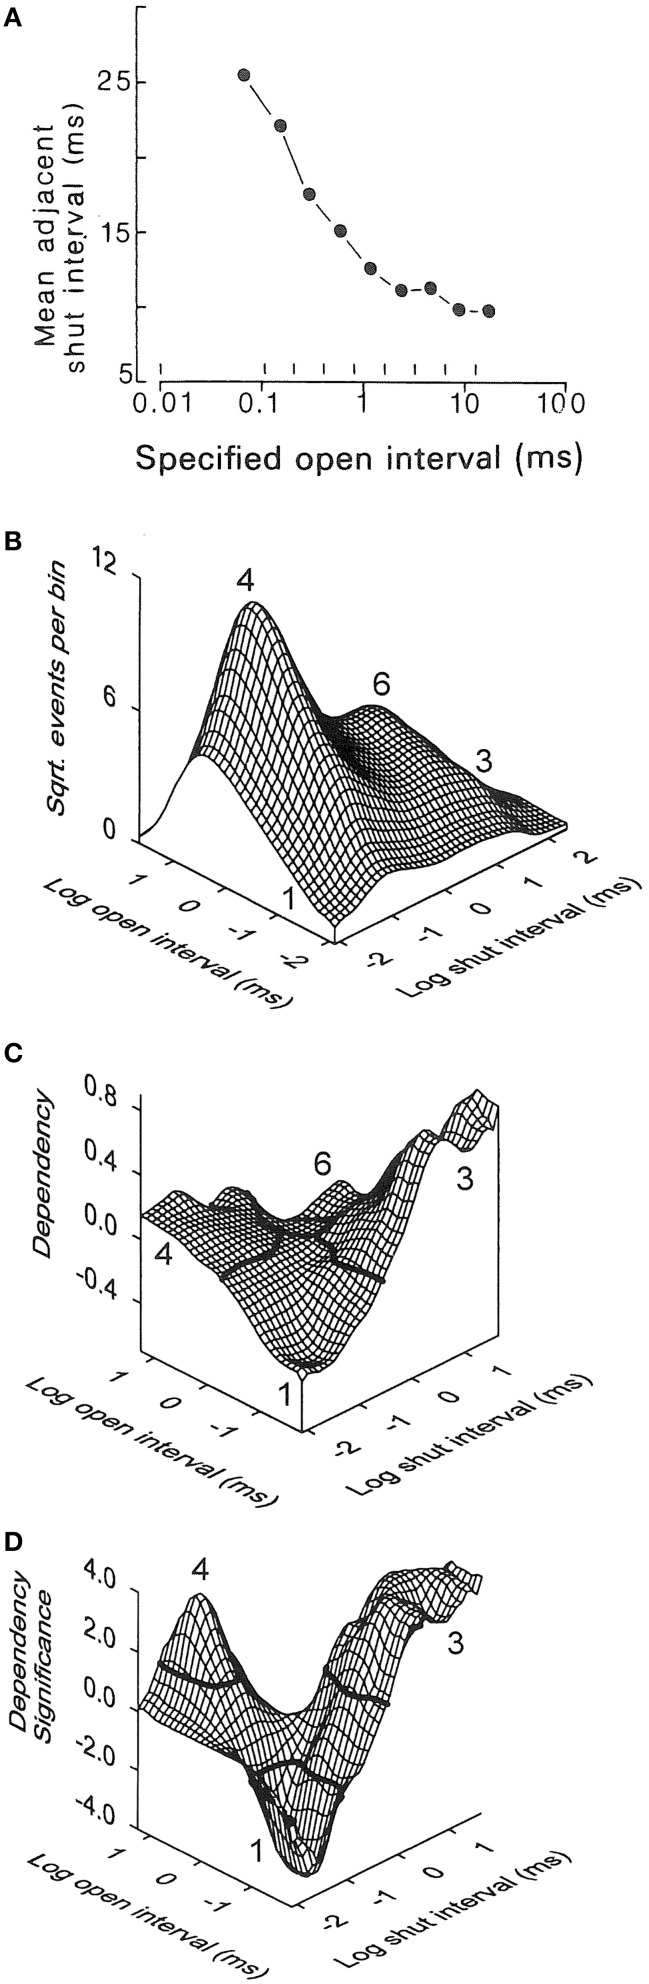
The inverse relationship between the durations of adjacent open and closed intervals suggests two-tiered gating with the lifetimes of the open states on the lower tier inversely related to the lifetimes of the closed states above them on the upper tier. (A) Inverse correlation between the mean durations of closed intervals adjacent to open intervals of specified durations delineated by the vertical lines near the abscissa. 0.7 μM Ca2+, +30 mV, 64,000 open and closed intervals were analyzed (from McManus et al., 1985). (B-D) Kinetic structure of a BK channel details the inverse relationship between durations of adjacent open and closed intervals. (B) 2D dwell-time distribution of adjacent open and closed interval pairs presented in a Sigworth and Sine transformation. The x and y axes indicate the logs of the means of the adjacent open and closed interval durations in each 2D bin. The ordinate gives the square root of the number of adjacent interval pairs in each 2D bin defined by the x and y axis. The greatest frequency is at number 4 for longer openings adjacent to briefer closings (12.3 μM Ca2+, +30 mV). (C) Dependency plot of the excess frequency of interval pairs over that expected if open and closed intervals pair at random. There were 45% more longer closed intervals adjacent to briefer open intervals (number 3), 15% more longer open intervals adjacent to briefer closed intervals (number 4), and 40% fewer briefer open intervals adjacent to briefer closed intervals (number 1), than would be expected by chance pairing. Dependency for any given bin is defined as the difference between the observed number of intervals in that bin minus the number of intervals expected for independent pairing, divided by the number expected for independent pairing. (D) The excesses of paired intervals in part C are significant (P < 0.05) for interval pairs above the solid black lines at numbers 3 and 4, and the deficits are significant for interval pairs below the solid black line at number 1. A significant deficit of longer open intervals adjacent to longer closed intervals (at number 6) cannot be seen on the back side of the plot. 28,560 intervals were analyzed (from Rothberg and Magleby, 1998b). The observed inverse relationships between the durations of adjacent open and closed interval pairs would be consistent with Schemes 4–6 if the closed state lifetimes in these schemes progressively decreased from left to right, and the open state lifetimes progressively increased from left to right.